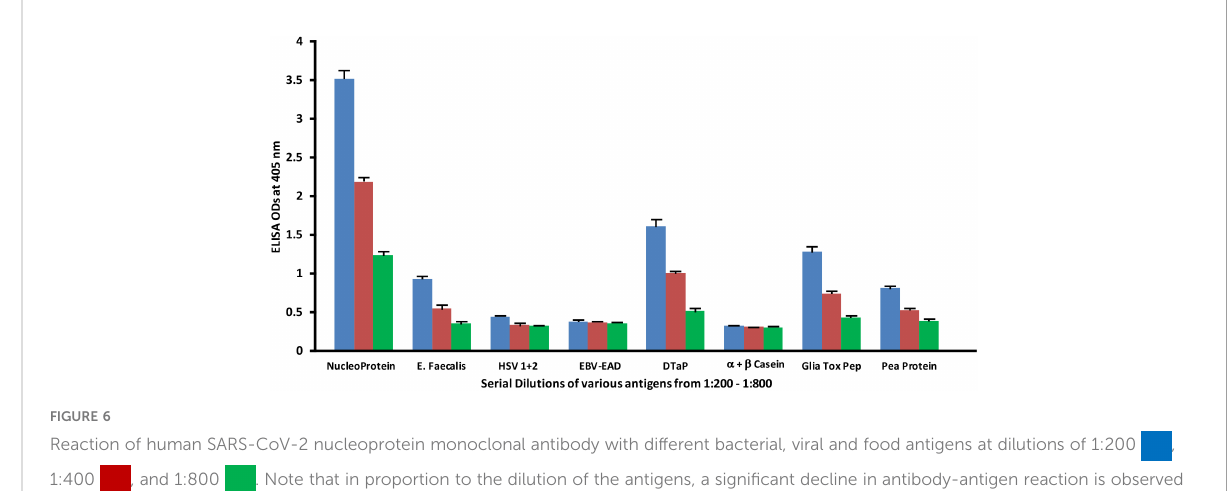
FIGURE 6 Reaction of human SARS-CoV-2 nucleoprotein monoclonal antibody with different bacterial, viral and food antigens at dilutions of 1:200